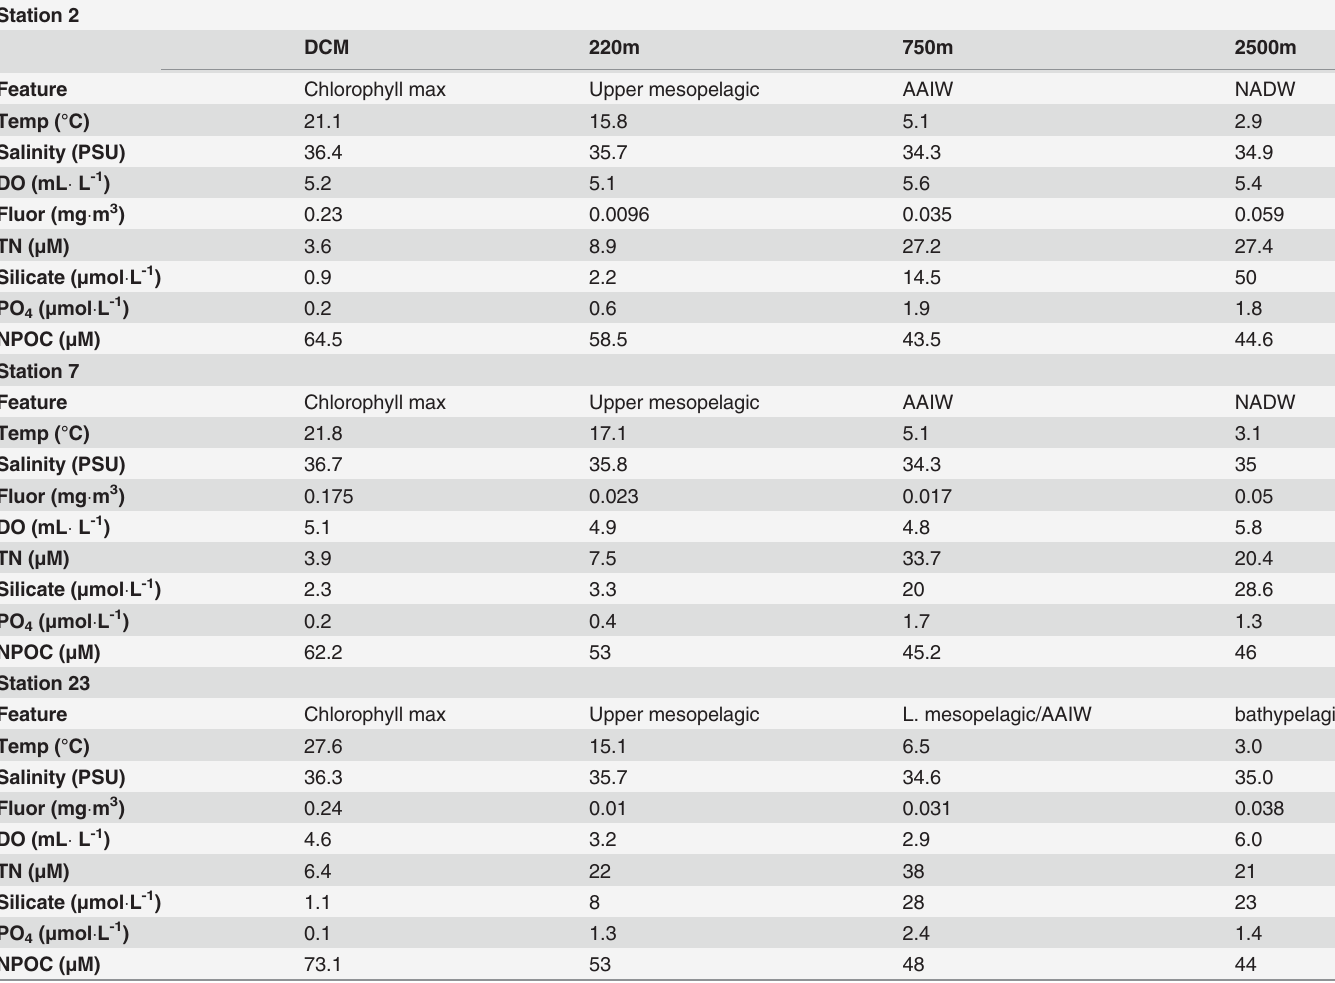
Table 1. Water features and metadata (temperature, salinity, dissolved oxygen (DO), total nitrogen (TN), silicate, PO 4 and NPOC (non-purgeable or- ganic carbon), for Stations 2, 7 and